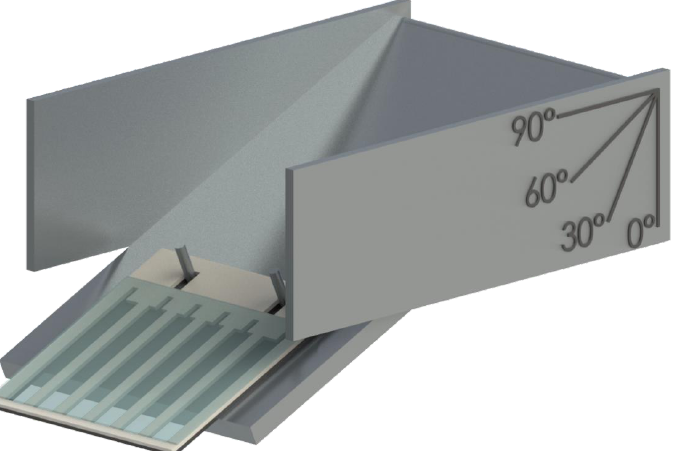
Figure A1. Angled wicking setup. The angled platform was held at the indicated angles by a removeable crossbar. The rig was mounted to the frame in the humidity chamber depicted in Figure 1. At 0°, 30°, and 60°, the water reservoir is raised on a jack to the bottom of the paper. For 90°, a saturated polyester sponge with an overhang was lowered by the jack until the overhang rested on the bottom edge of the paper.